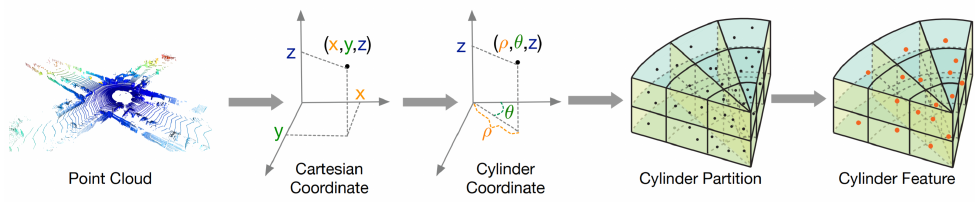
Figure 10. Cylinder3D [77] space partition.